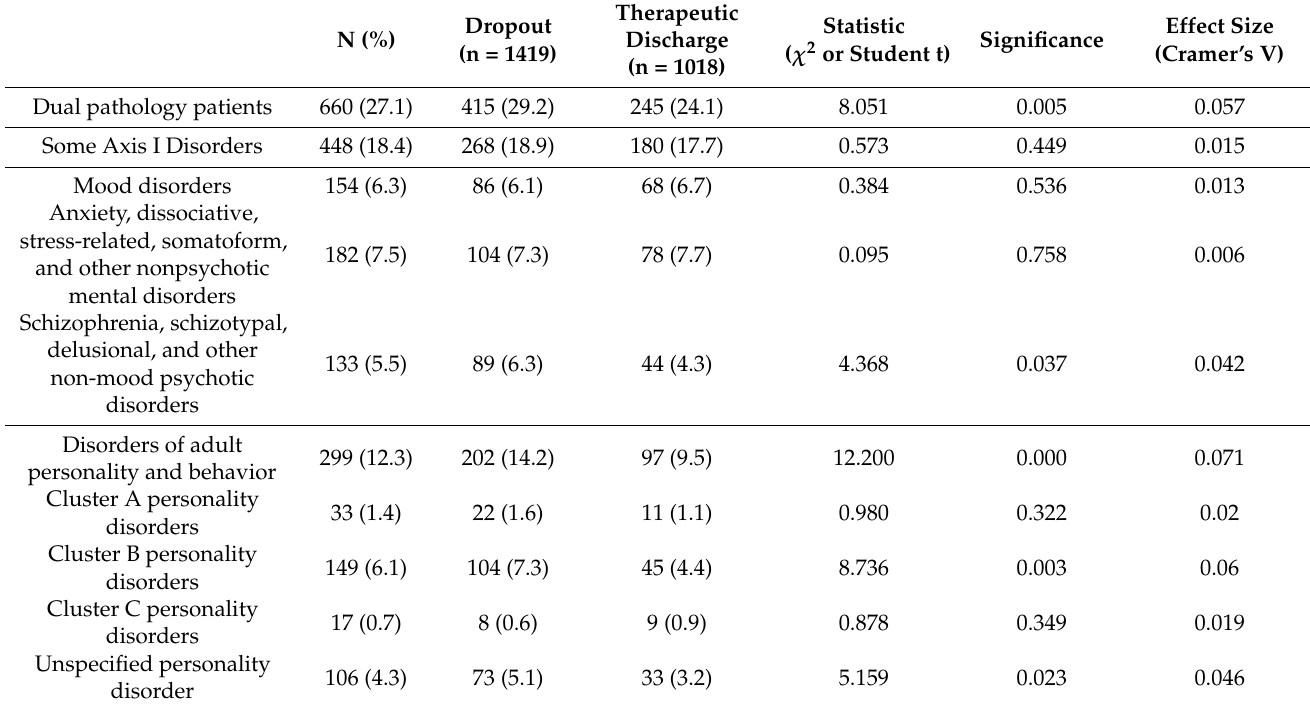
Table 2. Comorbid mental disorder disorders according to type of